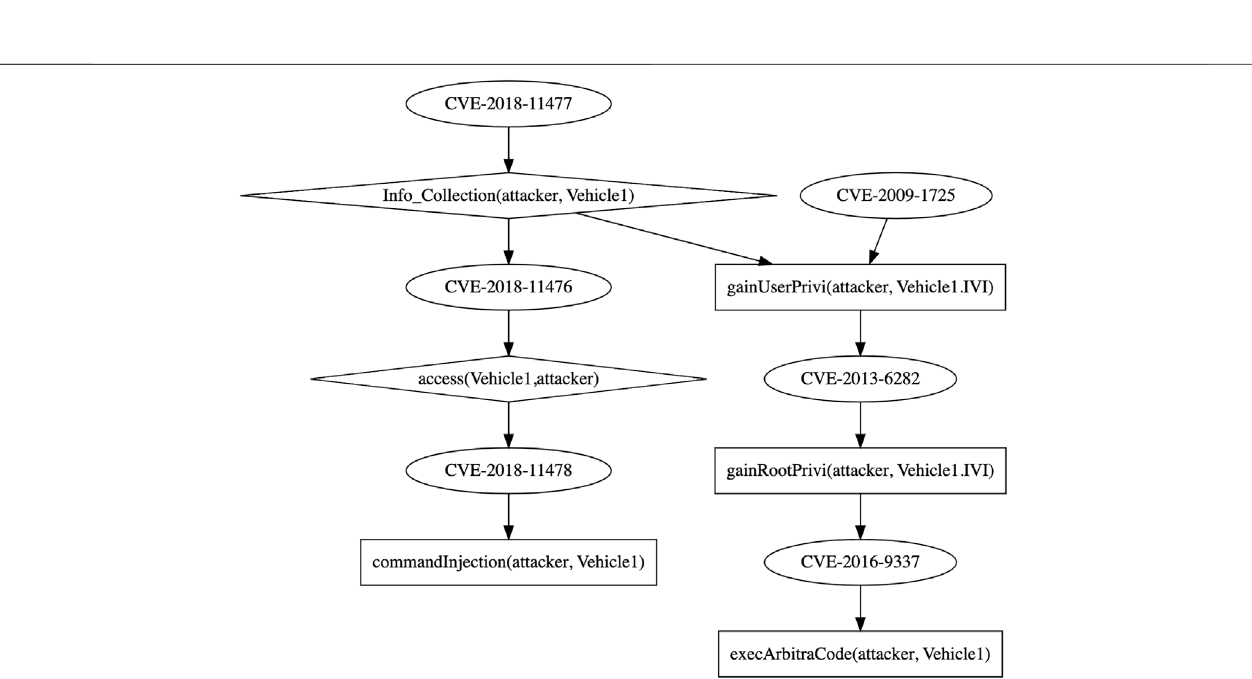
FIGURE 6 | Attack graph at time T 1